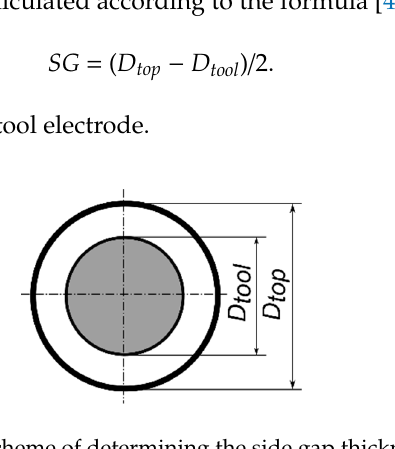
Figure 5. Scheme of determining the side gap thickness.